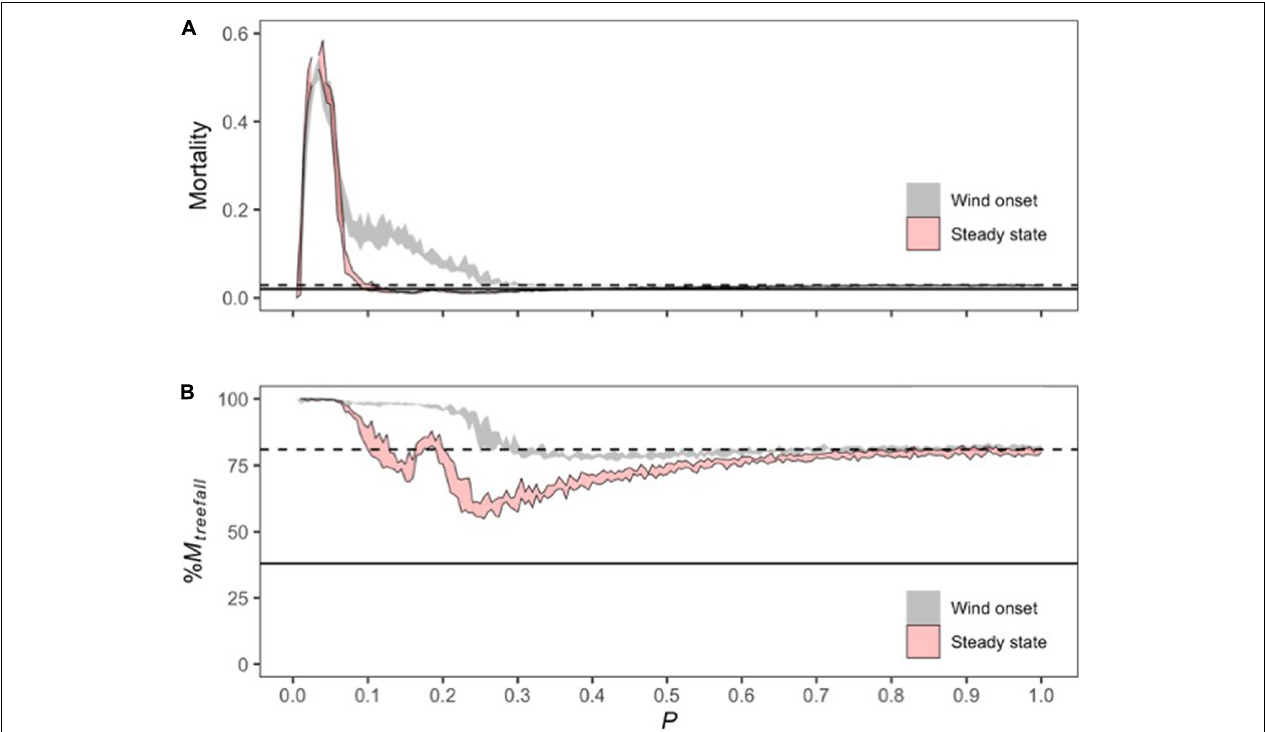
FIGURE 2 | (A) Mean annual mortality rate and (B) fraction of mortality attributed to treefalls (% M treefall ) for trees with DBH > 10 cm, in relation to the critical wind speed parameter P (smaller P means stronger effect). Shaded areas represent the value range of five replicates for each simulation condition. Black without border: mean values of the first 100 years after wind onset (year 101–200). Red with border: mean values of the last 100 years of simulation (year 401–500). Dashed lines represent simulation value with no wind disturbance, and solid lines represent field